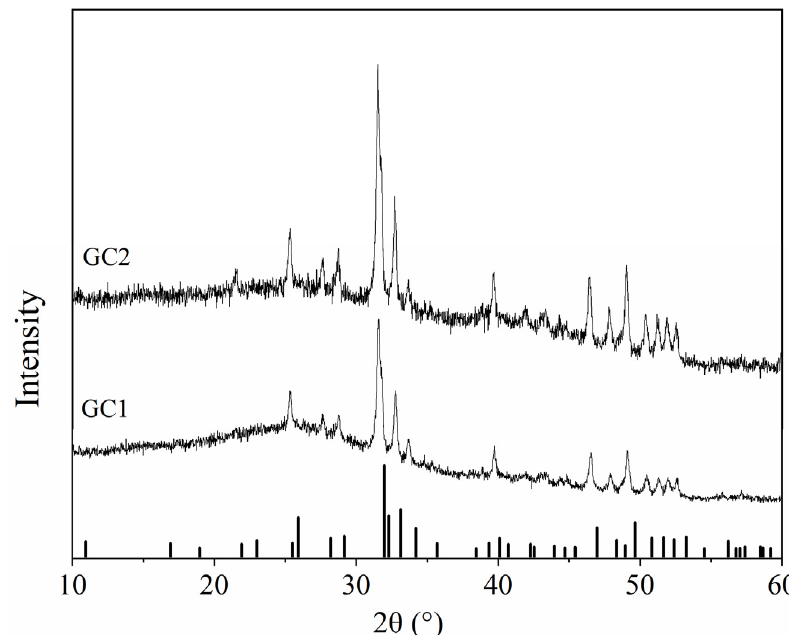
Figure 1. Conventional XRD patterns of pristine GC1 and GC2 samples.